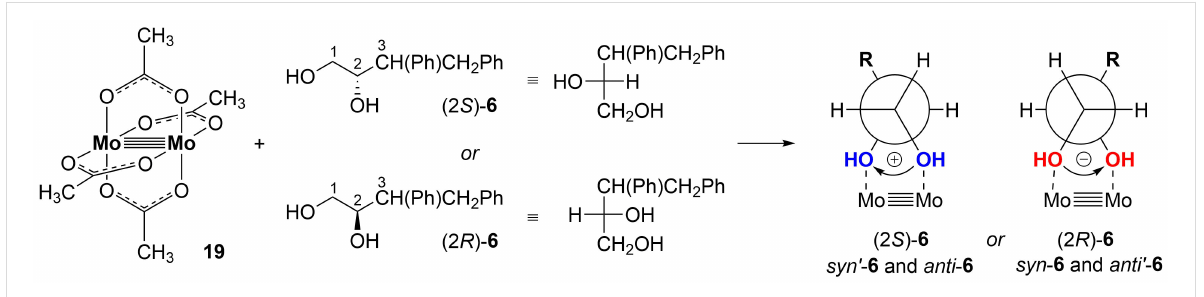
Scheme 5: Schematic representation of the in situ methodology and preferred conformation of diols with Mo 2 core.